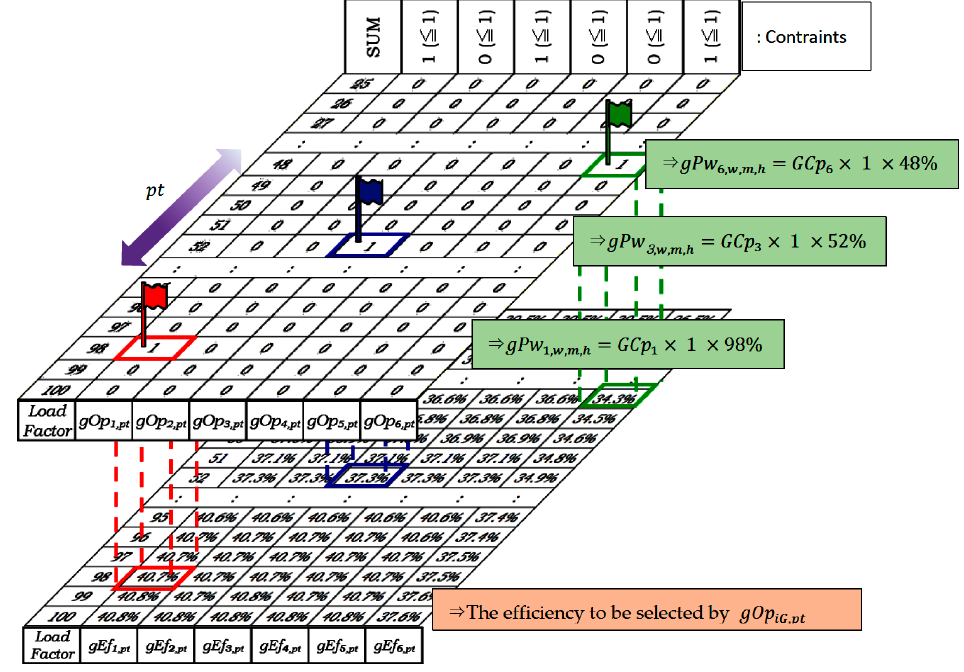
Figure 2. The example of selection the parameter of efficiency for each discretized values of load factor.